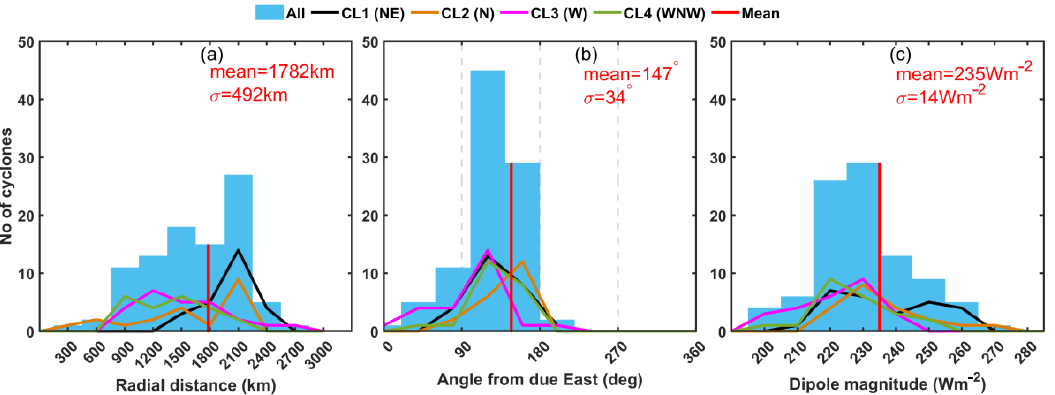
Figure 8. Histogram represents the dipole characteristics of outgoing longwave radiation (OLR) such as ( a ) dipole distance (km), ( b ) dipole orientation (deg), and ( c ) dipole magnitude (Wm −2 ) for 93 TCs. Lines with different colours represents the variation in dipole properties foe each cluster.